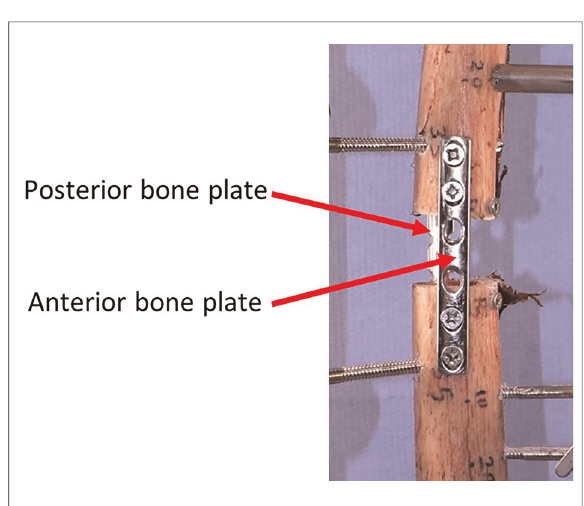
FIGURE 5 Securing the interfragmentary gap before removing the fi rst device to install the second